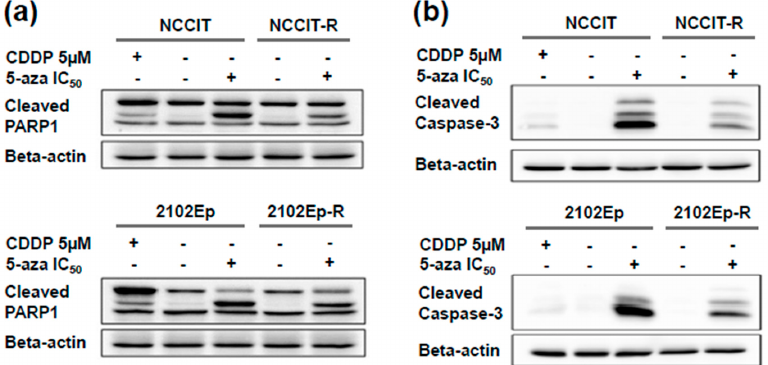
Figure 2. Nanomolar 5-aza treatment causes apoptosis induction in all four tested cell lines. Both ( a ) PARP1 cleavage, and ( b ) caspase-3 cleavage occur after 72 h of treatment with the respective IC 50 of 5-aza. Graphically, the amount of cleaved protein appears slightly decreased in the isogenic cisplatin-resistant sublines NCCIT-R and 2102Ep-R when compared to their sensitive counterparts. 5-aza is a strong inductor of apoptosis. Cells treated with 5 µ M cisplatin (CDDP), a supralethal dose, served as positive controls for the induction of apoptosis. Int. J. Mol. Sci. 2018 , 19 , x FOR PEER REVIEW